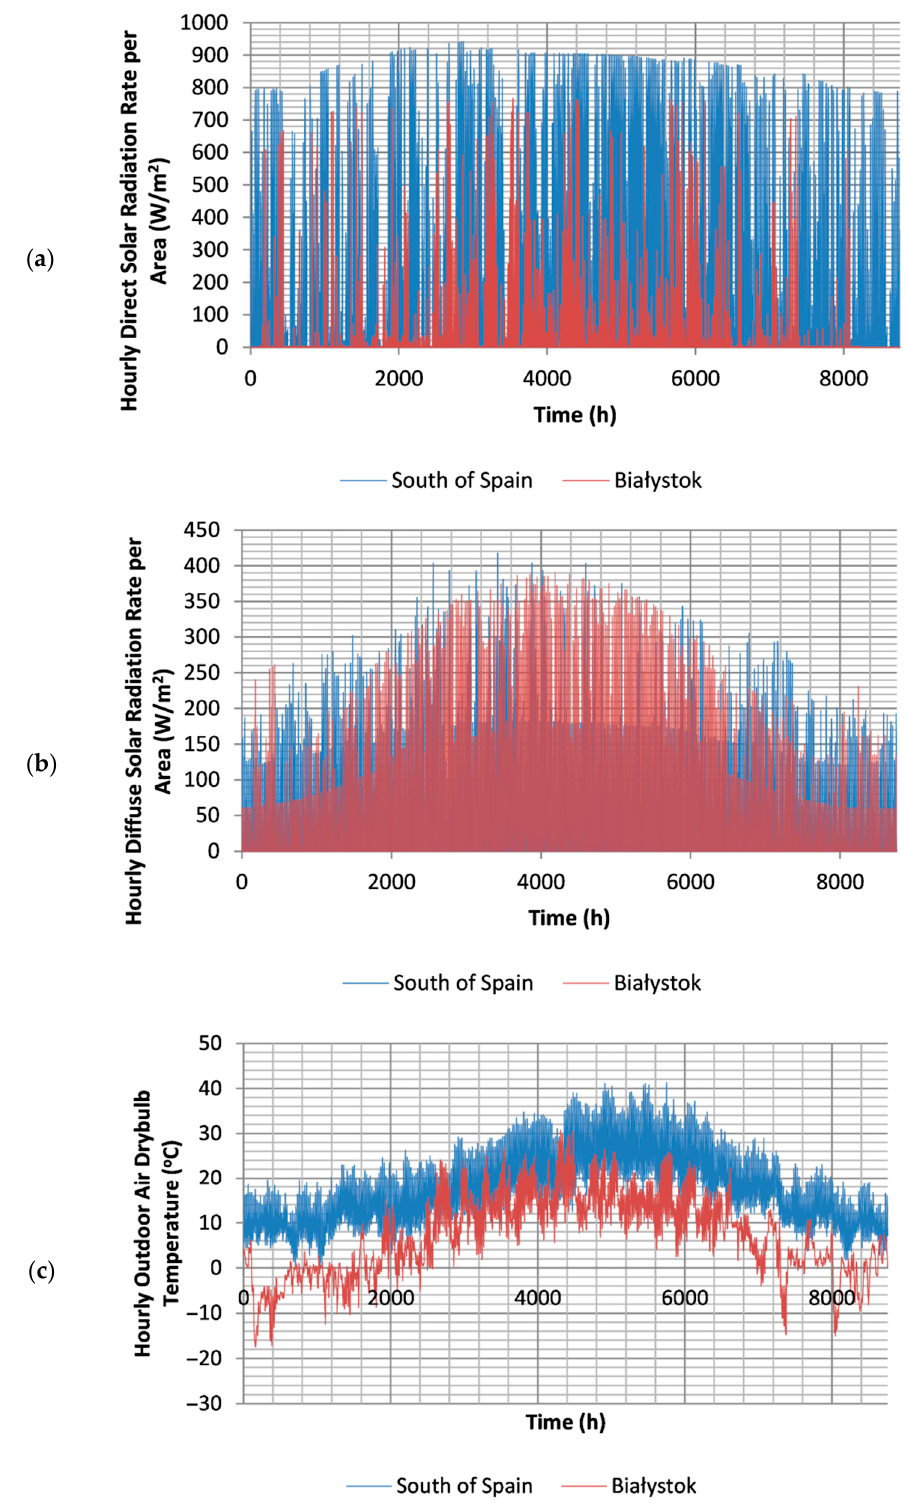
Figure 11. Hourly annual distribution of direct solar radiation ( a ), diffuse solar radiation ( b ) and outdoor temperature ( c ).